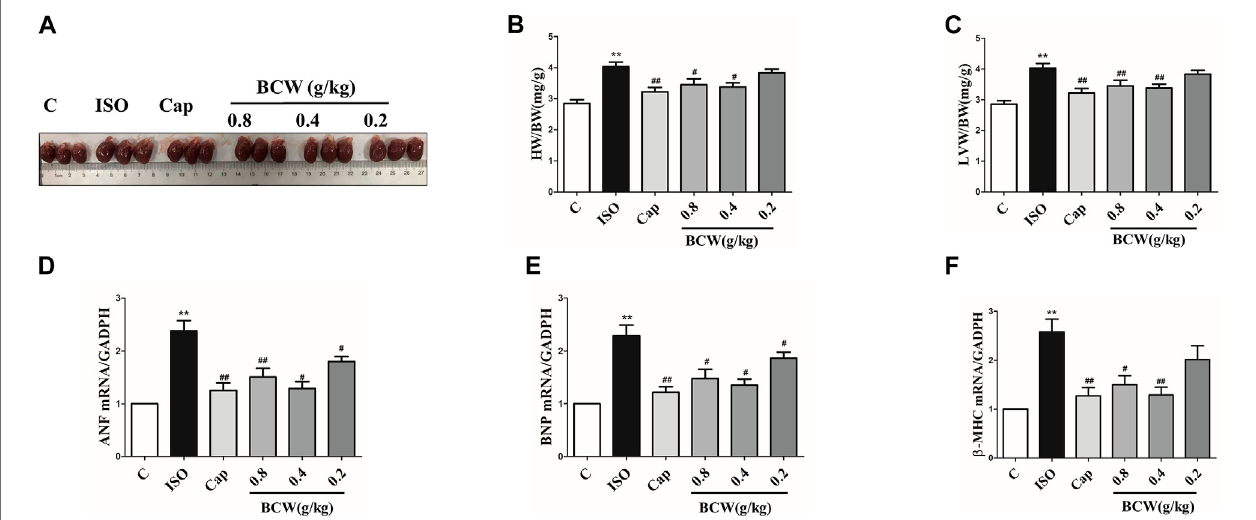
FIGURE 2 | BCW treatment alleviated ISO-induced myocardial hypertrophy. (A) Gross hearts from all groups of rats. (B and C) Quanti fi cation of heart weight to body weight ratio and left ventricle heart weight to body weight ratio. (D and E and F) Real-time polymerase chain reaction analysis of the mRNA expression of ANF, BNP , and β -MHC . Data were normalized by GADPH for mRNA expression and presented as mean ± SE, * p < 0.05 vs. control, ** p < 0.01 vs. control; # p < 0.05 vs. ISO, ## p < 0.01 vs. ISO, n (cid:2) 10.